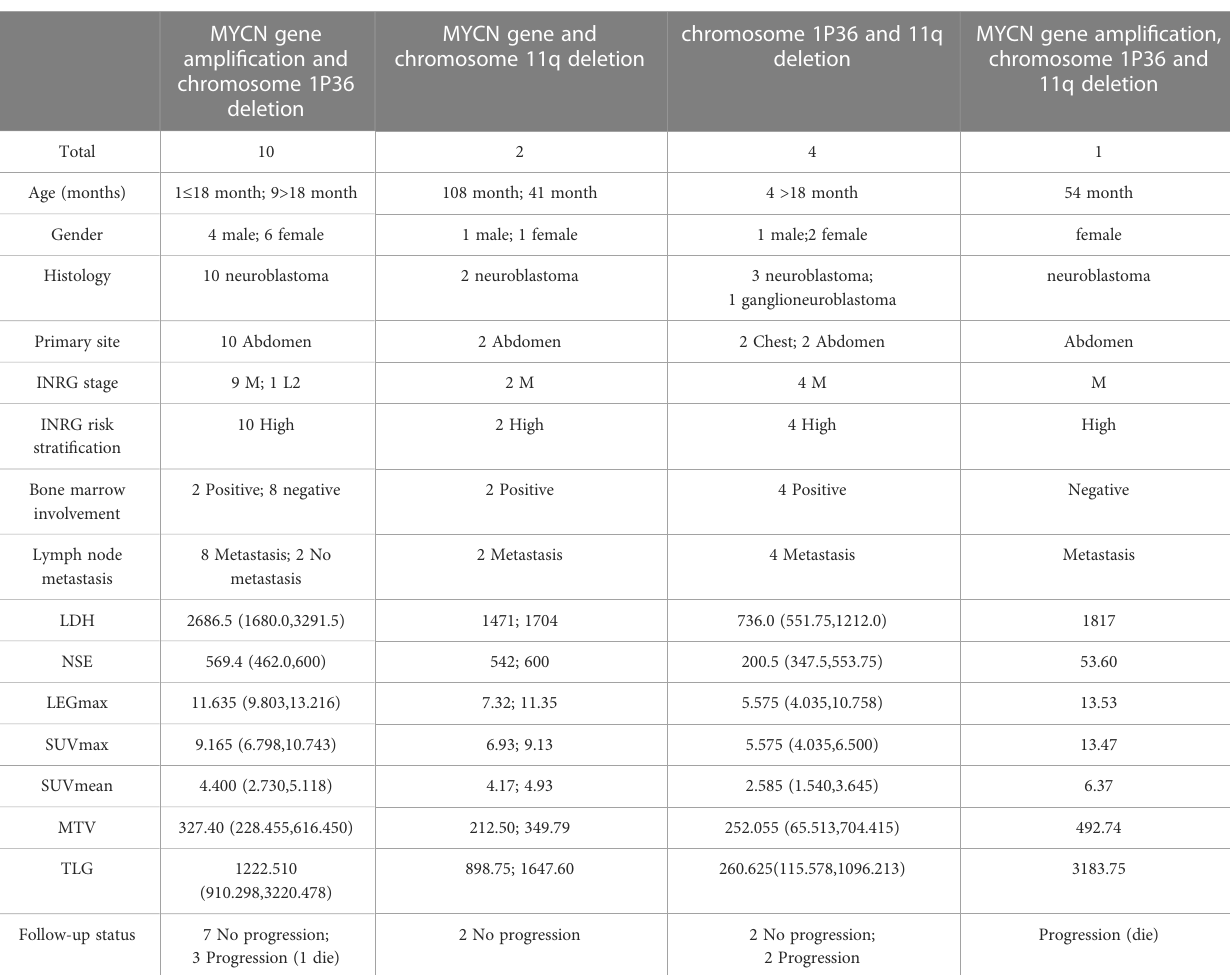
TABLE 5 The clinical biological characteristics and 18 F-FDG PET/CT metabolic parameters of the different combinations with the status of MYCN gene and t chromosomes 1p36 and 11q. MYCN gene ampli fi cation